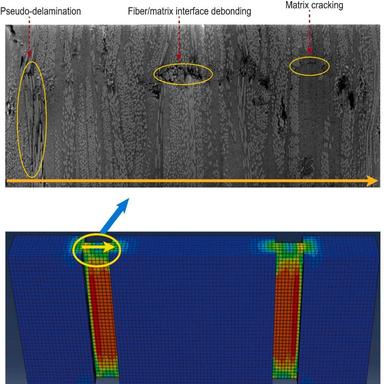
Damage phenomenon in of A-SMC composite under shear loading.